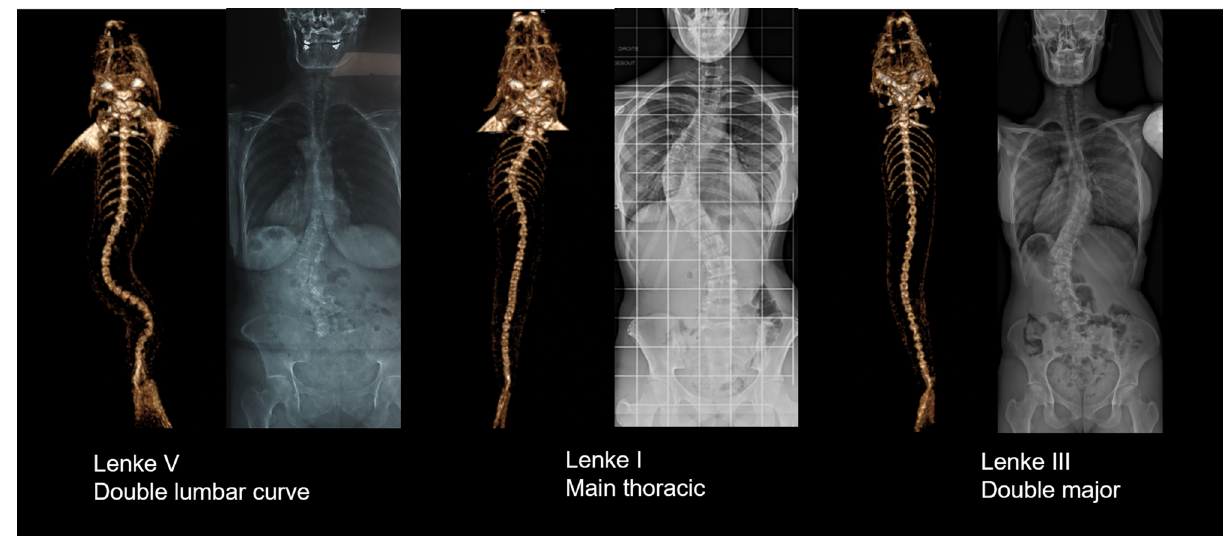
Figure 1. Three examples of frontal 3D-reconstructions of zebrafish’s spine deformities, classified according to Lenke and compared to corresponding human scoliosis. Left: Reconstructions from RaDiant Dicom Viewer 5.0.0 software (https:// www. radia ntvie wer. com/); Right: Clinical plain radiographs (personal collection of Radiological confirmation of a suspected scoliosis relies on the observation of a three-dimensional and rota- tional spinal deformity characterized by a thoracic curvature in the frontal plane with a Cobb angle greater than 10 degrees on frontal radiographs 1,3 . Here, we observed that 63% of the cfap298 tm304 population analyzed (n = 17 out of 27 animals) had three-dimensional spinal deformity in the frontal and sagittal planes (Fig. 2A, B), with curves exceeding 10 degrees in the frontal plane (42.1° ± 4.1°, [min–max: 23°–78°]). In the scoliotic population analyzed, we observed that most of the animals had double or triple curves (n = 13 out of 17 scoliotic fishes) (Fig. 2C). If classified as human adolescent idiopathic scoliosis, 29% of the curves were Lenke 3, 29% Lenke 4, 18% Lenke 5, 6% Lenke 1 and 6 or 1 and 2 animals were unclassifiable according to Lenke classification 27 . The Fig. 1 displays some example of the Lenke classification applied to Zebrafish spine. To fully describe the curve pattern of scoliotic animals, we measured the amplitude of the main curve at 8 weeks old, and observed it was larger when the apex was located in the thoraco-lumbar junction (Fig. 2D), reflecting the anatomical location of the main curve observed in the patients. Moreover, the magnitude of the main curve for the 17 scoliotic zebrafishes was 42.1° ± 4.1°, [min–max: 23°–78°], while we observed a mean angle of 36.5° ± 6.7° [min–max: 13°–77°] for the first minor curve and 27.9 ± 4.8°, [min–max: 16°–43°] for the second compensatory curve. Spinal deformities associated with AIS in human pathology are also characterized by a progression of the curve severity over time, most notably during the period preceding the pubertal growth spurt 29 . Thus, we ana- lyzed the evolution of the curve severity on scoliotic cfap298 tm304 animals between 8 and 12 weeks of age. The mean length of the zebrafishes (all cohort) at 8 weeks old was 15.3 mm ± 1.86; [11.7;18.9 mm] and 19.8 mm ± 3.37 [12.4;25.5 mm] at 12 weeks old. We observed that the mean Cobb angle of the scoliotic cfap298 tm304 zebrafish increased by 5.5° ± 7.3° (mean ± SEM) during this period, showing the progressive development of spine tor- sion. The mean Cobb angle for the second curve at 12 weeks was 47.6° ± 13° [29; 82°]. Moreover, the mean apical vertebral rotation for the main curve was 31° ± 13° [min–max: 20°–69°], reflecting its three-dimensional shape. The analysis of the curve patterns at 12 weeks also showed that spine curves remained mainly thoracic or thoraco-lumbar with double or triple curves and that 82% of the scoliotic juvenile fishes presented at least one dislocation (Fig. 2E). The dislocations were located at the thoraco-lumbar junction or at the lumbar spine for 79% of the animals. Another feature of AIS is its sexual dimorphism. While female are a least more likely to develop scoliosis by a ratio of two 30,31 and most severe curves are ten times most prevalent in females than males 32 and the risk of progressive deformity requiring surgical treatment is five times higher in girls than in boys 33 . Thus, we compared the frequency of scoliosis occurrence in male and female siblings obtained from the cross of cfap298 tm304/ + and cfap tm304/tm304 parents (Fig. 3A). At 8 weeks old, 76% (n = 13 out of 17 animals) of scoliotic fish were females, compared to 30% in the non-scoliotic population (n = 3 out of 10), suggesting a female bias in the penetrance of scoliotic curves. Moreover, only 4/13 (31%) of the male fishes developed scoliosis, compared to 13/14 (93%) of the females, that difference being statistically significative according to Fischer’s test ( p = 0.001 ). Although curve patterns may vary in AIS patients, right-sided thoracic deformities are by far the most common 34 . Figure 3B shows the distribution of the convexity of the main thoracic curve in cfap298 tm304 scoliotic animals, which was located to the right in 71% of the scoliotic fish. Overall, these results showed that the cilia-defective cfap298 tm304 mutant displayed characteristics of spinal curvature defects observed in human AIS patients.